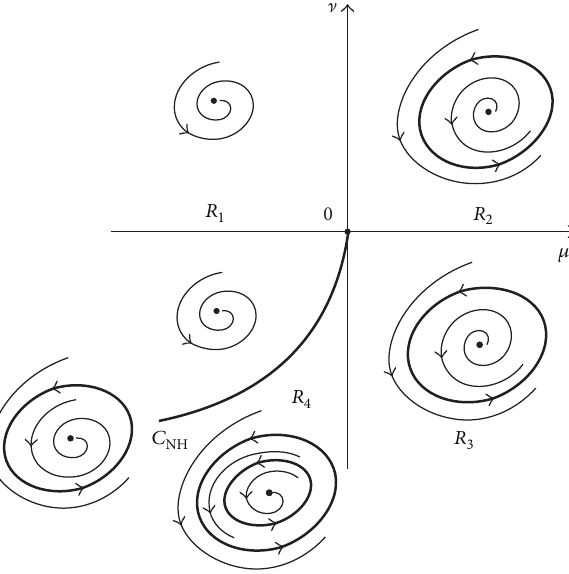
Figure 2: Bifurcation diagram of the Li´enard equation (139).